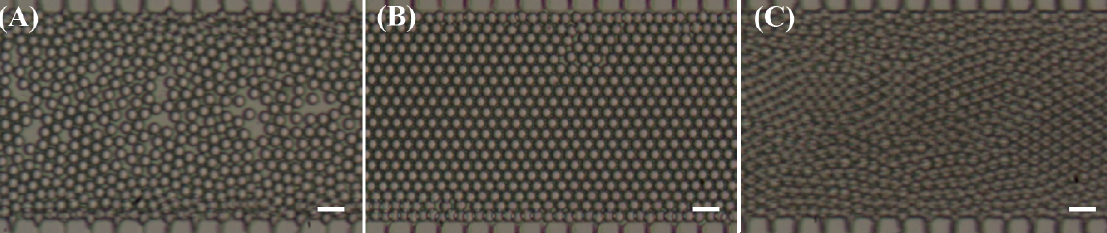
Figure 5. Series of the optical microscopic images of the monodispersed